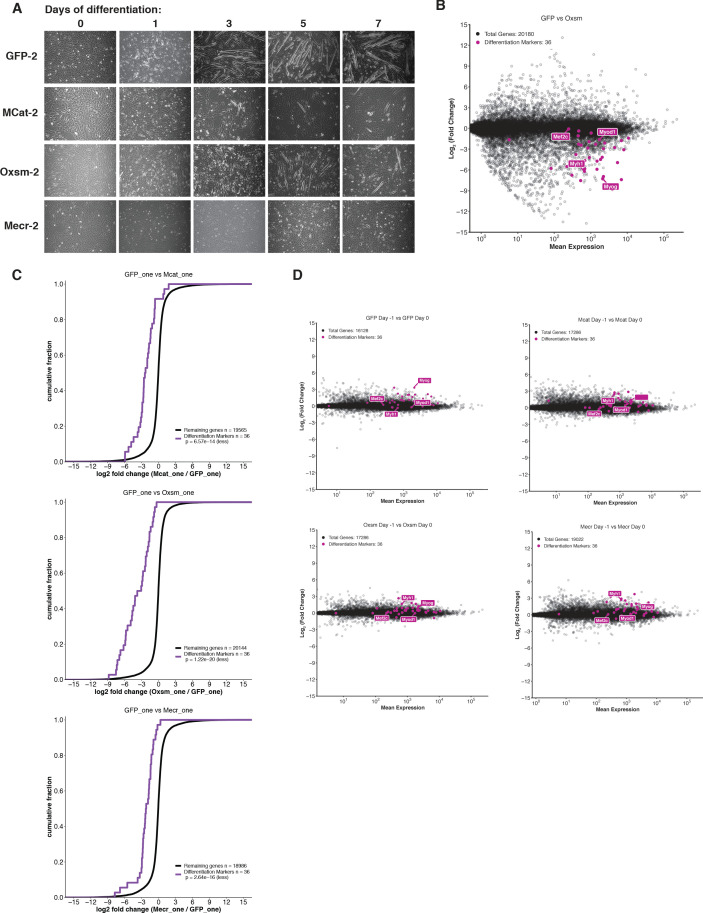
Skeletal myoblast differentiation is delayed in mtFAS mutant cell lines.(A) Cells of the indicated genotypes were plated and grown for 24 hr under proliferative conditions (day −1), then switched to 2% horse serum differentiation medium at 95% confluency (day 0). Medium was replaced daily for the indicated number of days. Plates were imaged at the indicated time points. (B-C) Quadruplicate samples from mtFAS mutant cells and controls were plated and allowed to adhere overnight, then harvested at Day −1 (proliferative,~70% confluency), Day 0 (~95% confluent), or Day one after switching to 2% horse serum differentiation medium for 24 hr. Total RNA was isolated, used as input for mRNA library prep, and sequenced. Resulting data were aligned to the mouse genome and analyzed for differential expression. Transcripts for differentiation related proteins from panel (A) are shown in purple vs. all other transcripts (gray). (B) Oxsm mutant vs. GFP controls after 24 hr in differentiating media. (C) Cumulative distribution plots of differentiation related transcripts vs. all other genes for the indicated genotypes, p>0.05, Wilcoxon rank-sum test. (D) Change in expression of transcripts from Day −1 to Day 0 for mtFAS mutant cell lines and GFP controls.